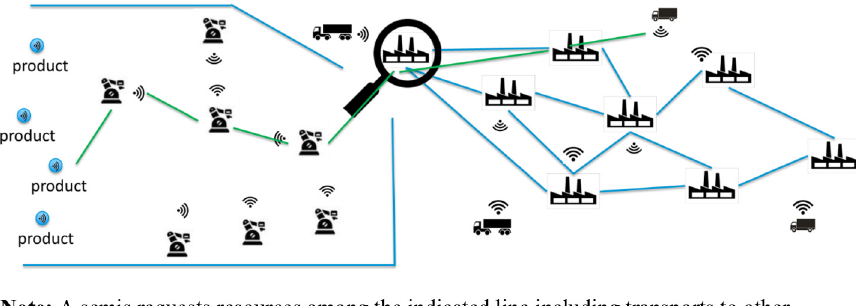
Figure 2. Example for a dynamic, de-centrally initiated and controlled production